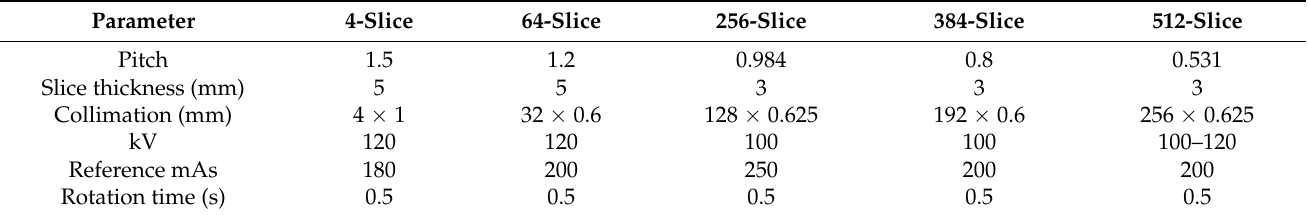
Table 1. CT scanner types and parameters.